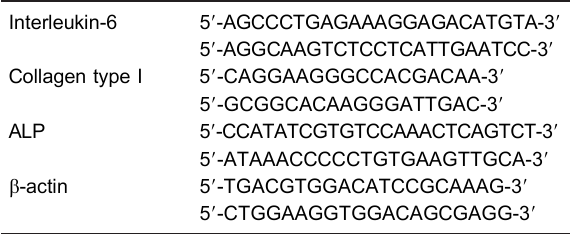
Table 1. Real-time PCR cycles were adjusted to have linear amplification for all targets.